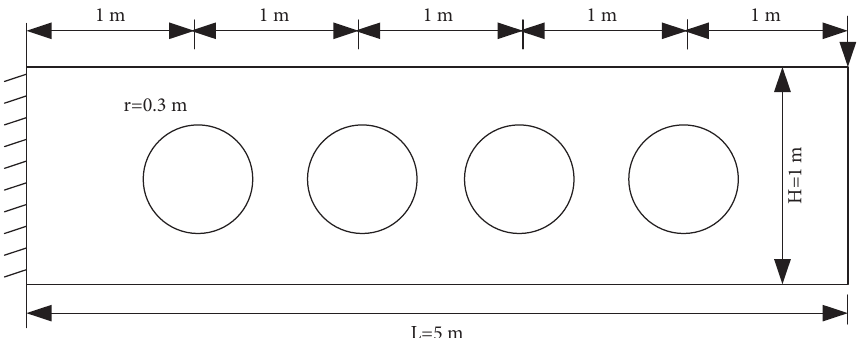
Figure 7: Geometry and boundary conditions of a multihole panel.